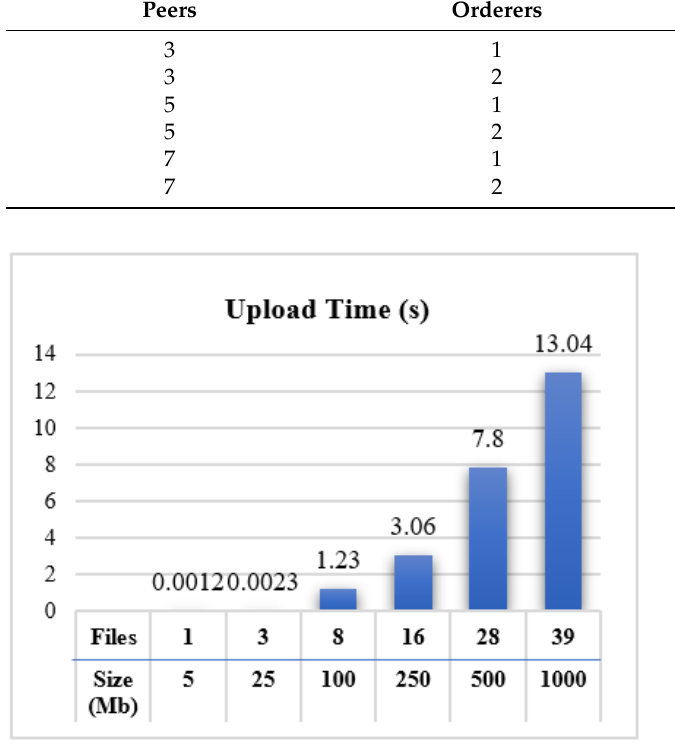
Figure 10. Uploading performance in seconds.